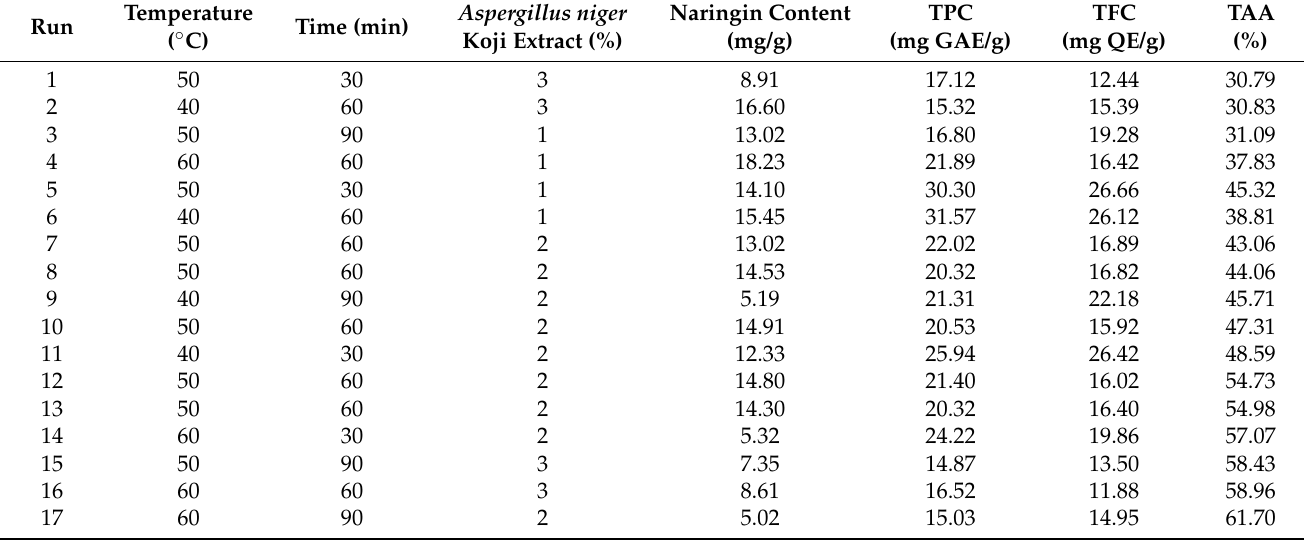
Table 2. Experimental values for naringin content, total phenolic content (TPC), total flavonoid content (TFC), and total antioxidant activity (TAA) of Kinnow peel extracts obtained through varying debittering